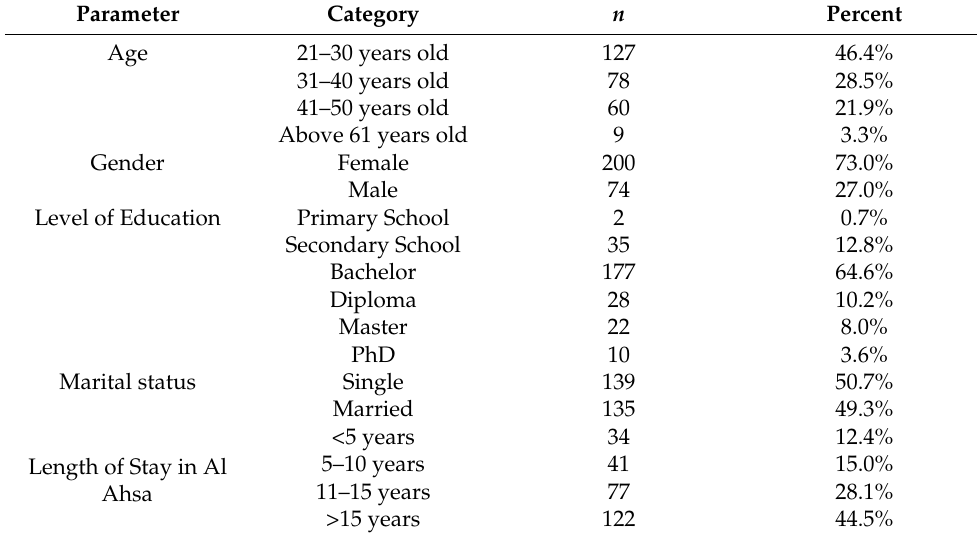
Table 1. Characteristics of the participants.